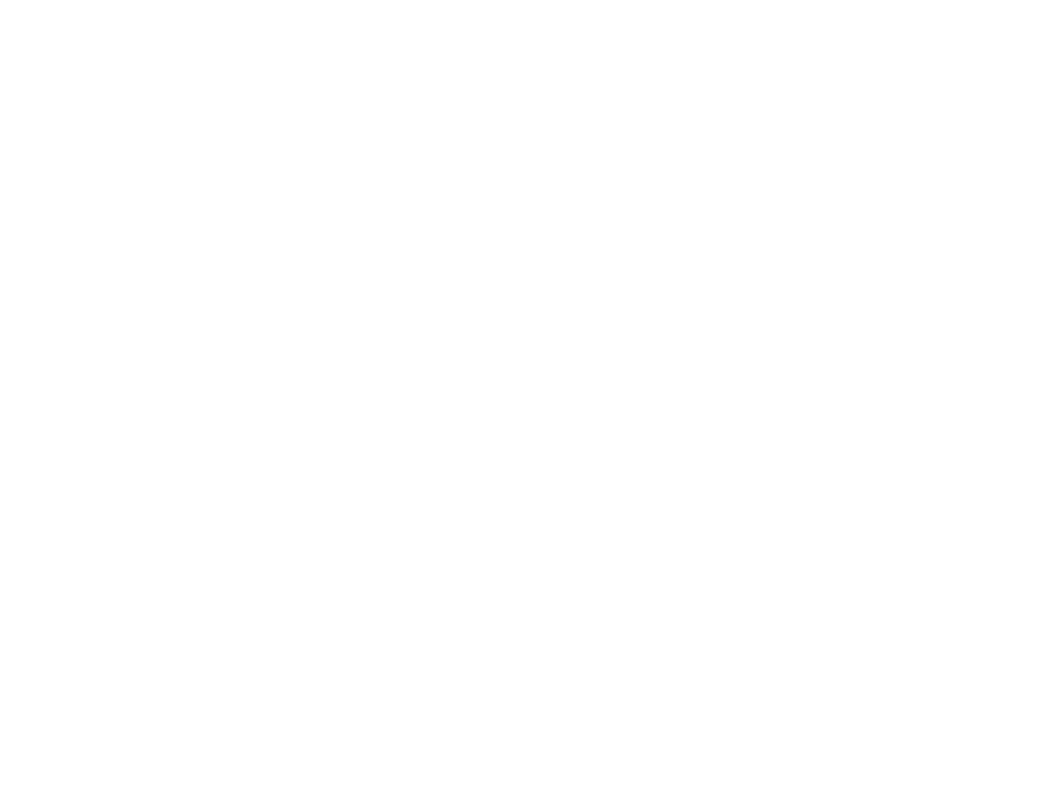
E x = 2.5 and ν x ν y = ( 0.3 ) 2 (cid:31)